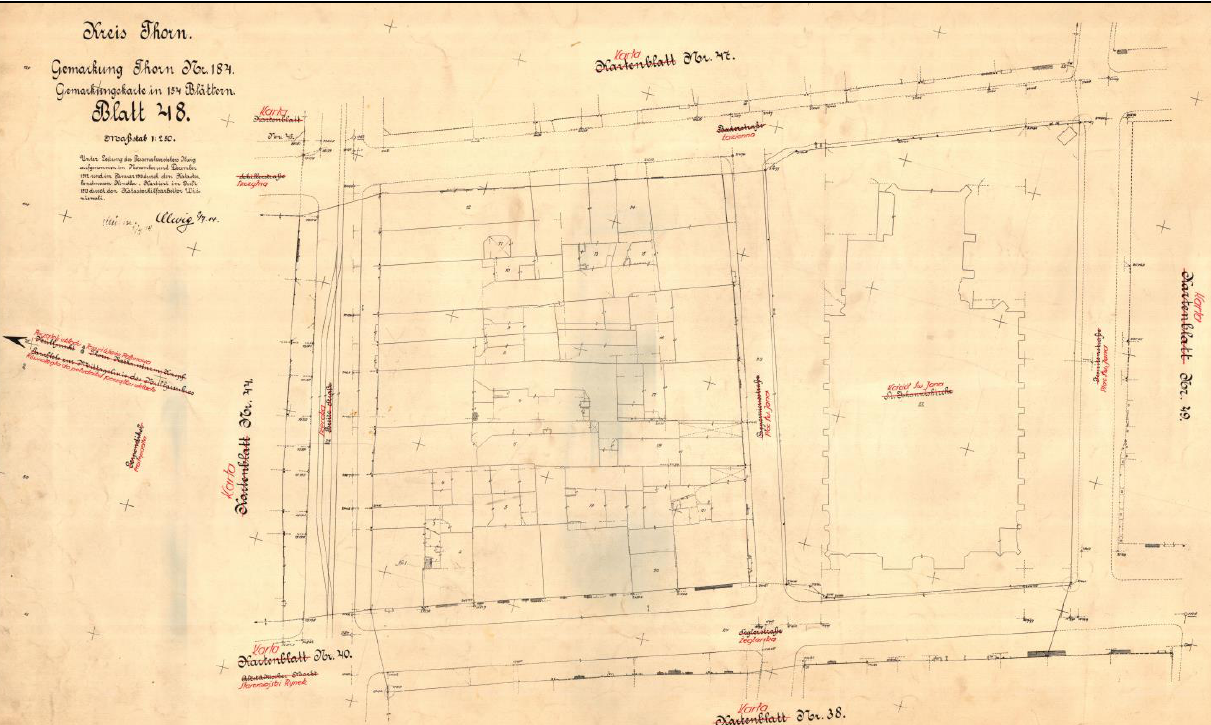
Figure 2. Sample sheet of the cadastral map of Toruń at a scale of 1:250. Source: Gemarkungskarte der Stadt Thorn, Blatt 48, State Archives in Toruń.